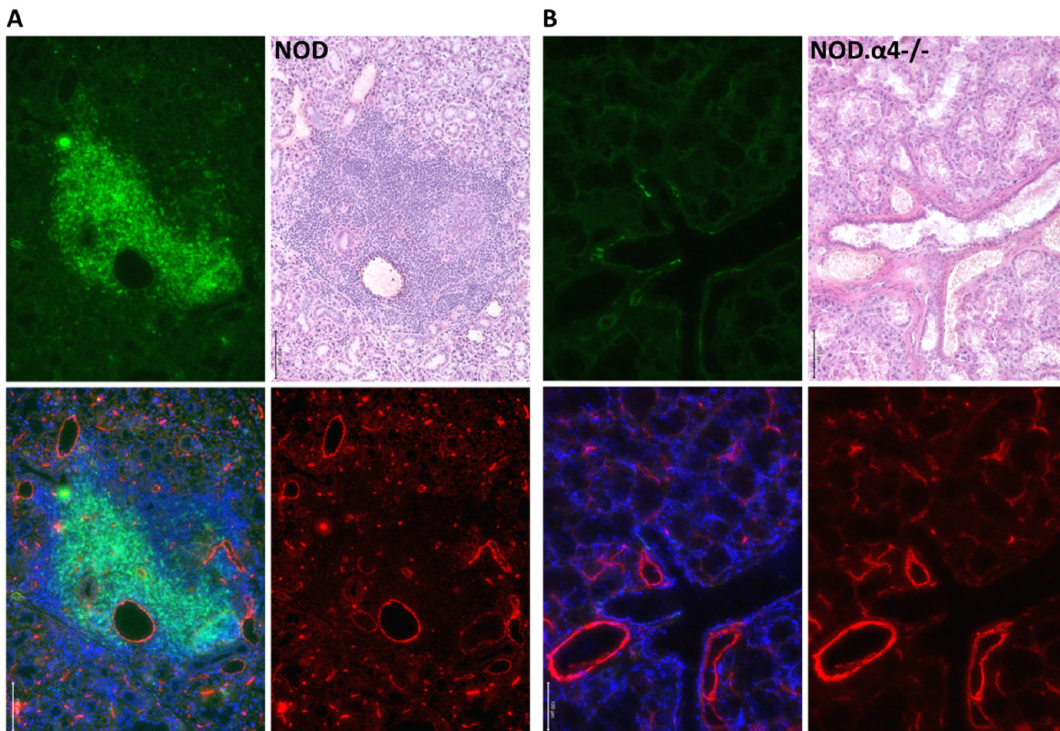
Figure 4. Submandibular gland immunofluorescence histology of young adult non-diabetic mice. Submandibular gland from NOD ( A ) and NOD. α 4- / - ( B ) young adults is shown, with a prominent lymphocyte infiltrate in ( A ). Adjacent sections were used for HE or immunohistochemistry staining (CD3: green, Meca32: red, merged fluorescence image including DAPI; 20 × original magnification; 100 µ m size bars in image).